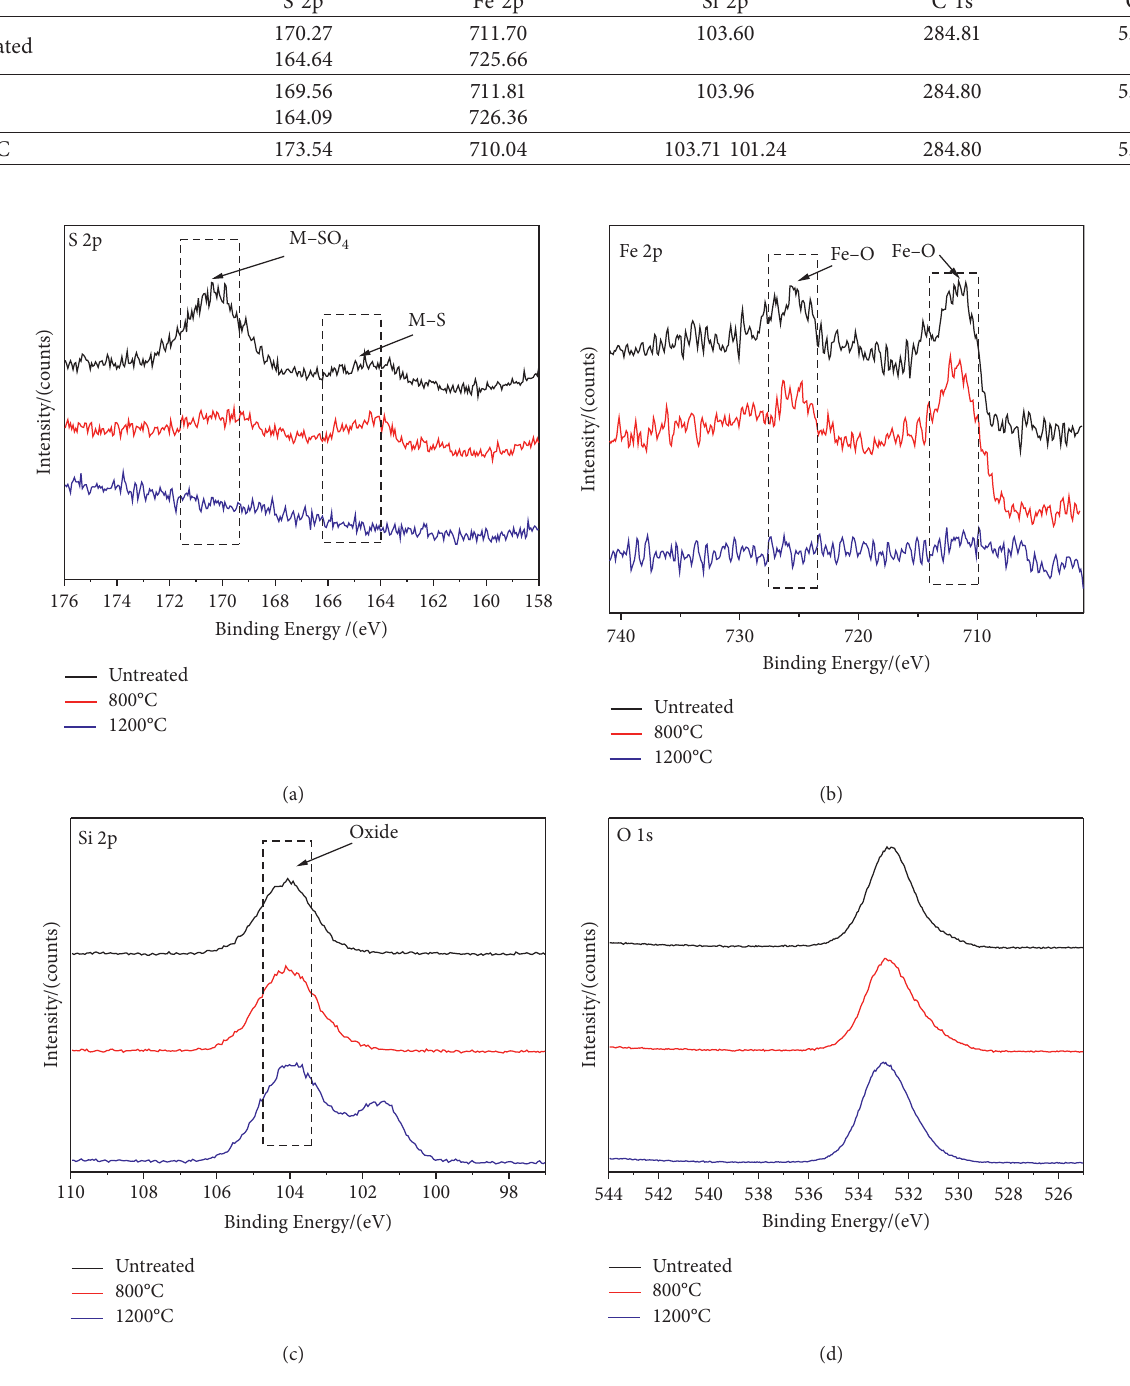
Figure 5: Spectra of S 2p, Fe 2p, Si 2p, and O 1s at different conditions.